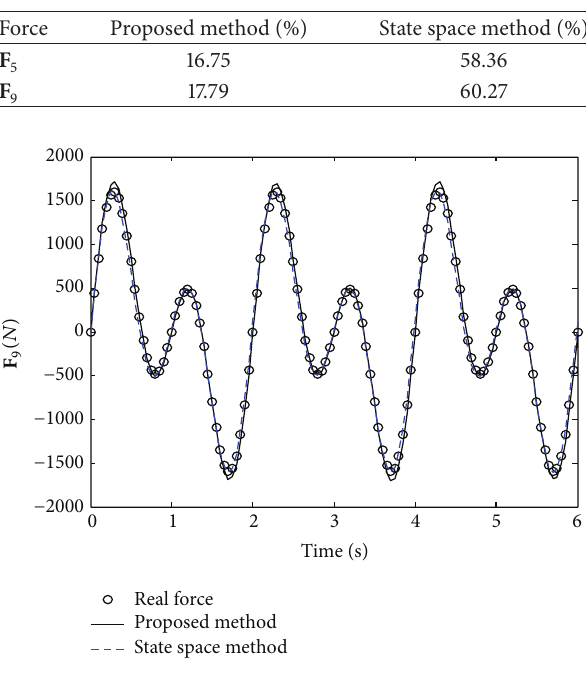
Figure 5: Force identification results of F 9